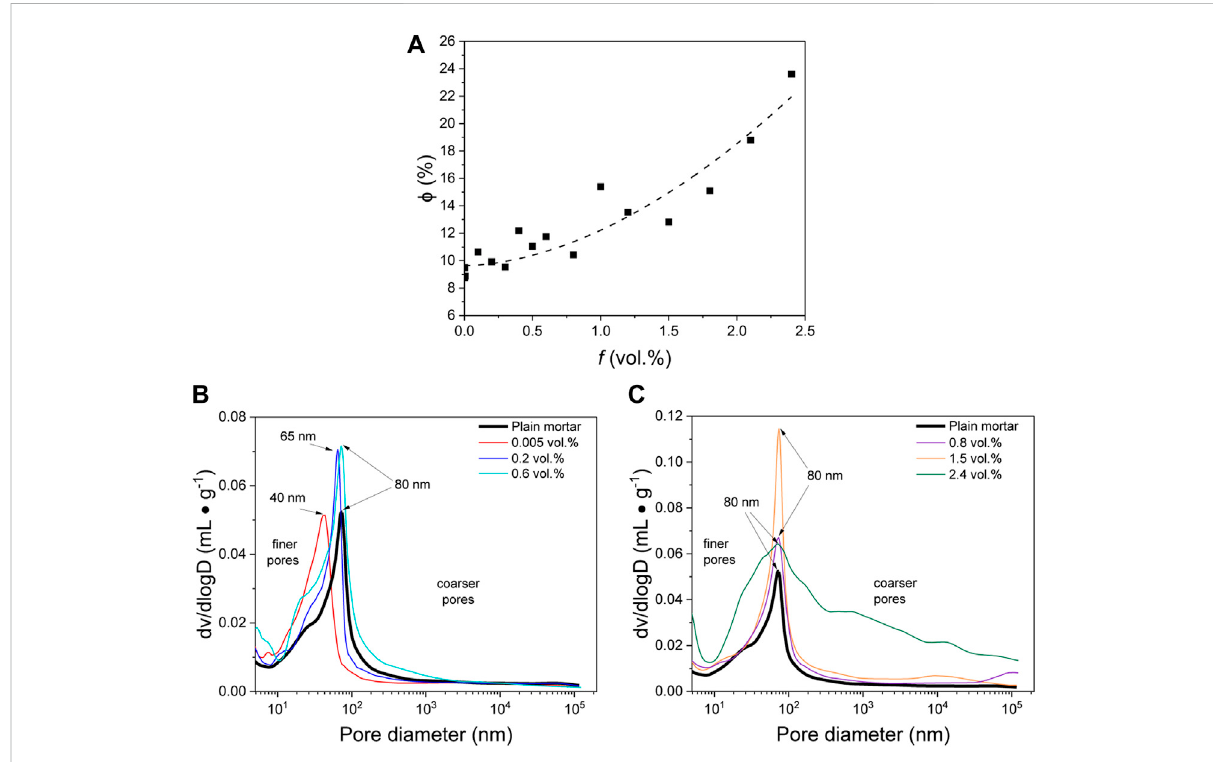
FIGURE 7 MIP results of the specimens at the curing age of 97 days (A) Development of capillary porosity ϕ with the increasing fi bre loading f (B) differentialporesize distribution atlower fi brecontents, CF0.005 vol%,CF0.2 vol%,andCF0.6 vol% as examples (C) differentialporesize distribution at higher fi bre contents, CF0.8 vol%, CF1.5 vol%, and CF2.4 vol% as